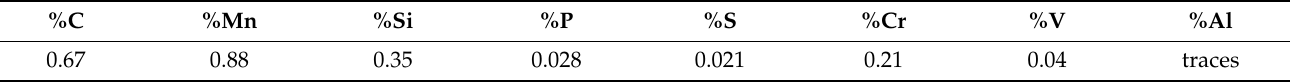
Table 2. Chemical composition of corroded